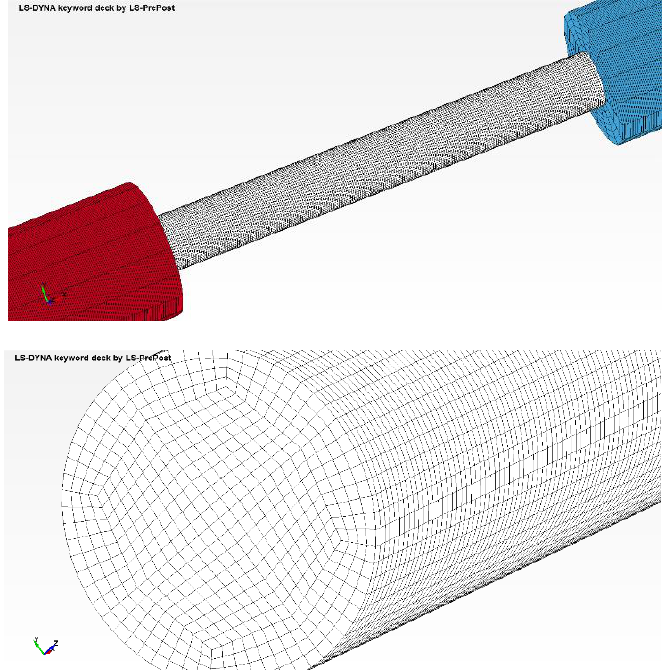
Figure 3. Detail view of the virtual model on the region of the sample ( up ) and nodes arrangements in the sample cross section ( down ).